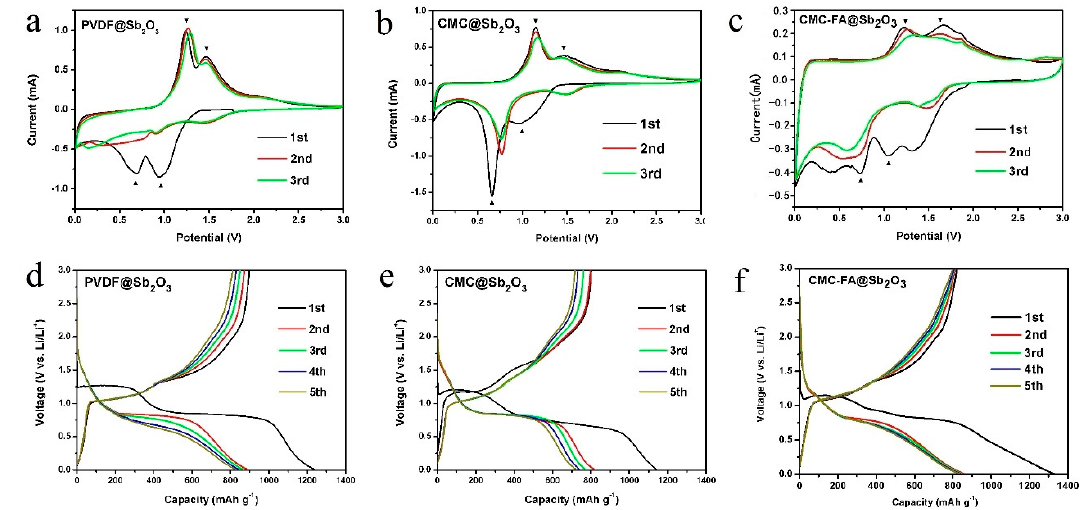
Figure 3. ( a – c ) Cyclic voltammetry curves of PVDF@Sb 2 O 3 , CMC@Sb 2 O 3 and CMC-FA@Sb 2 O 3 at scan rate of 0.2 mV s − 1 ; ( d – f ) galvanostatic charge-discharge profiles of PVDF@Sb 2 O 3 , CMC@Sb 2 O 3 and CMC-FA@Sb 2 O 3 in the initial five cycles at 0.2 A g − 1 .